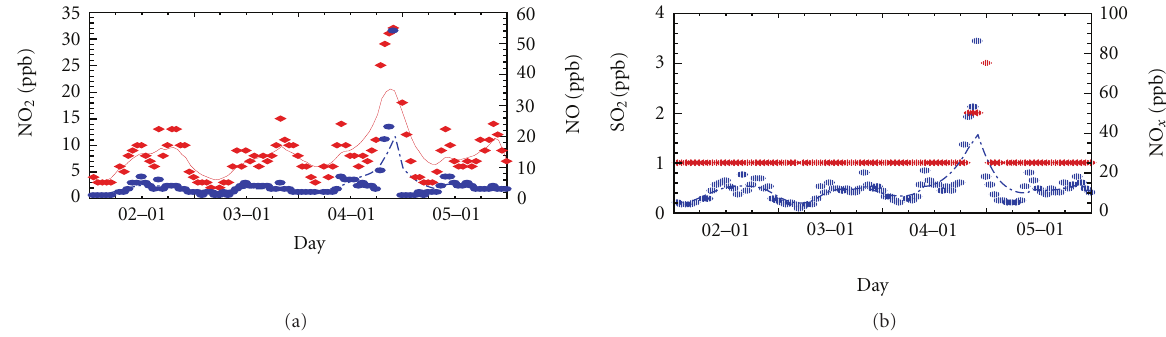
Figure 10: Hourly averaged series of pollutants concentrations during a winter period in Sousse city. Time evolution of the left y axis is plotted with solid line, and the right one is plotted with dashed line.